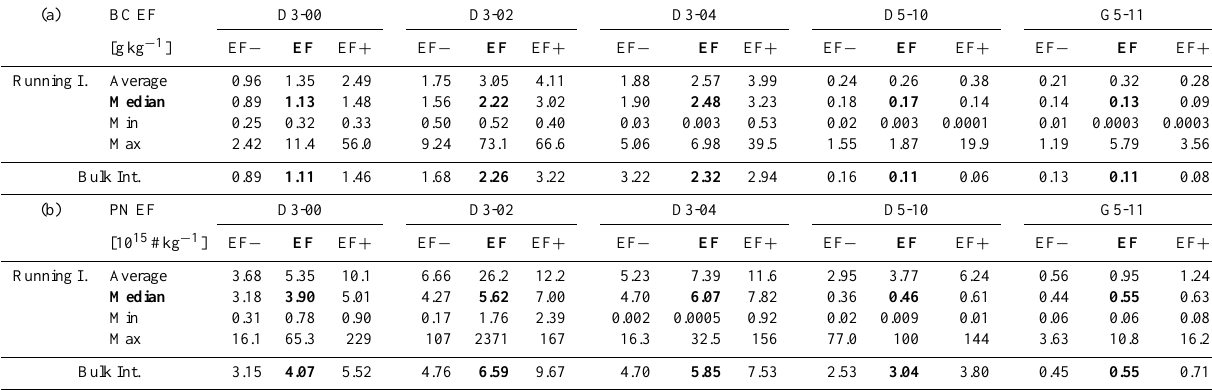
Table 3. Summarized results of the chasing measurements. BC (a) and PN EF (b) are reported as the average, median, minimum and maximum of the running integration method and the result of bulk integration. In column headers EF, EF − , and EF + denote the subtracted background used for the calculation of the EFs. For background influence analysis we first subtracted the linear fit of average background values measured before and after the chase (EF) then we tested it by subtracting (EF − ) or adding (EF + ) 2 standard deviations to the background value. The median EFs for each car are denoted in bold for